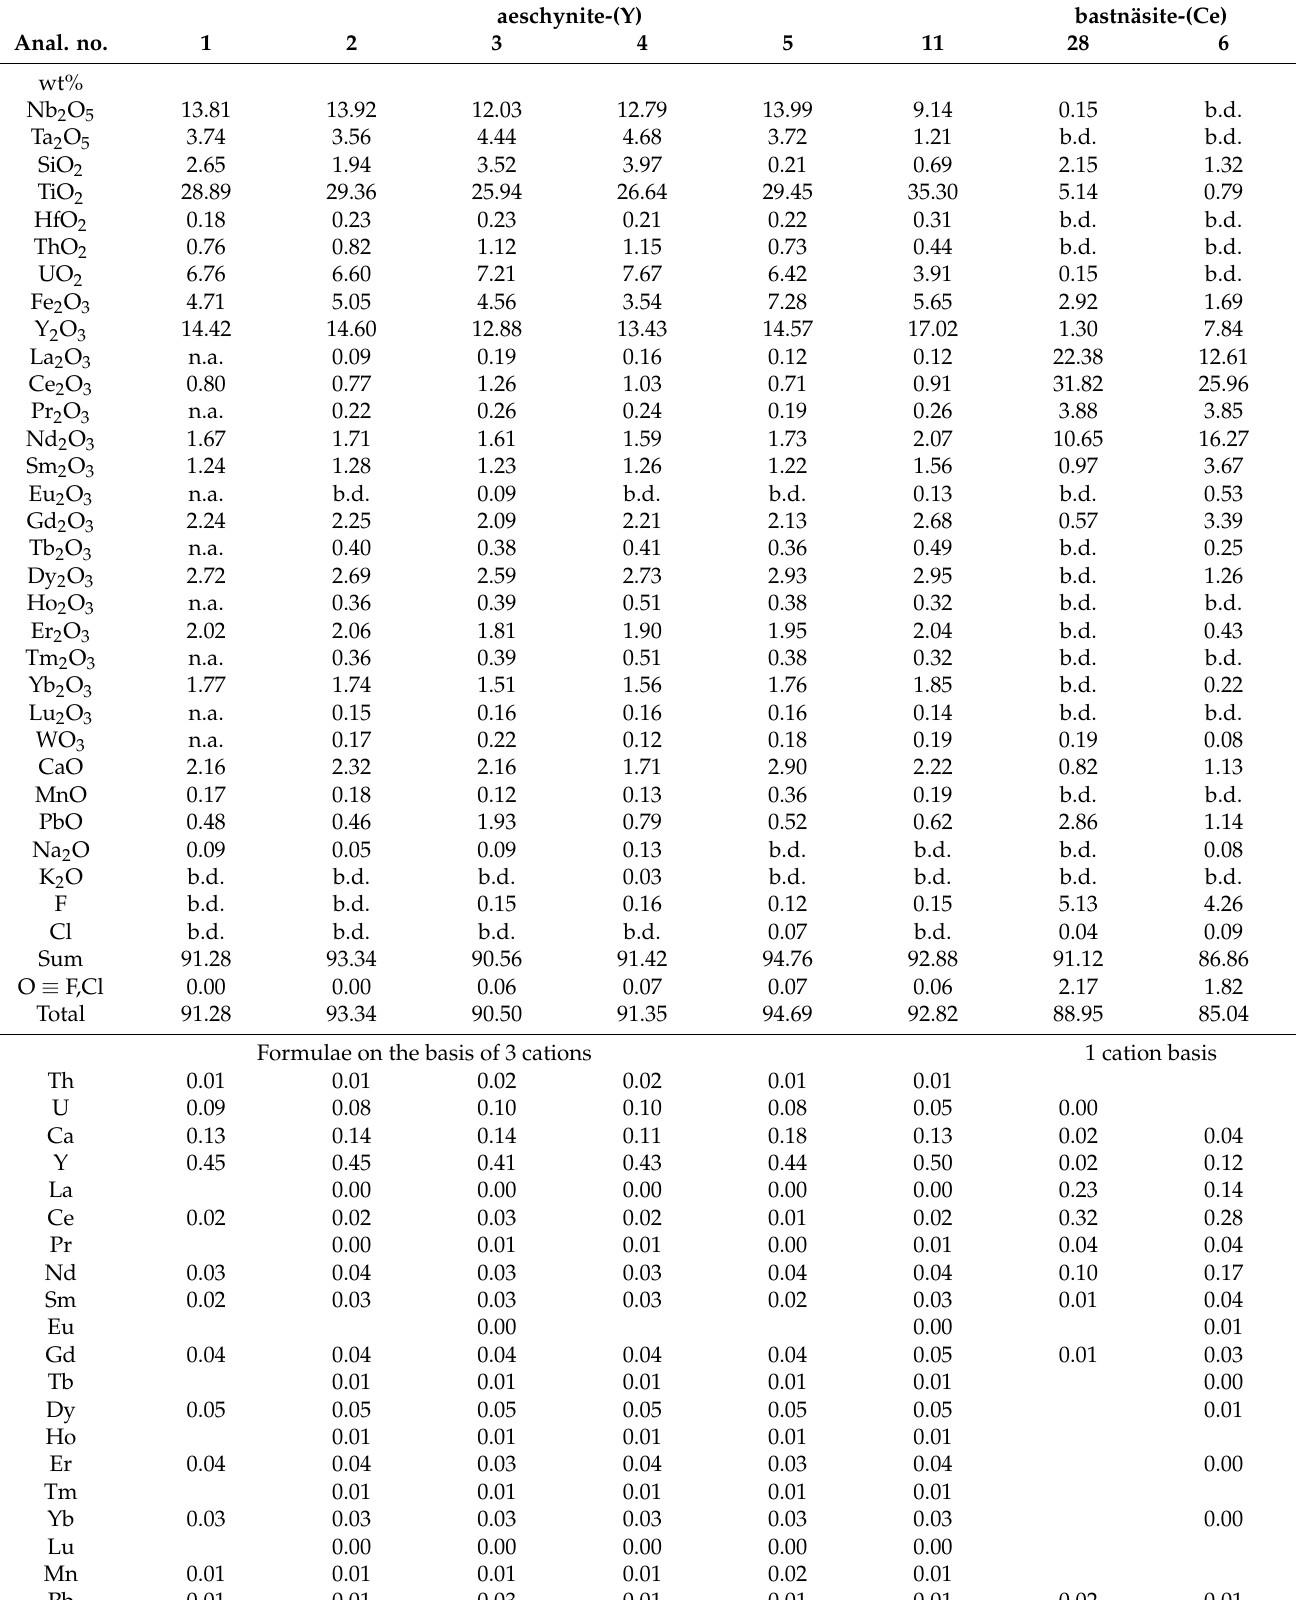
Table 3. Compositions of aeschynite-(Y) and bastnäsite-(Ce). aeschynite-(Y)